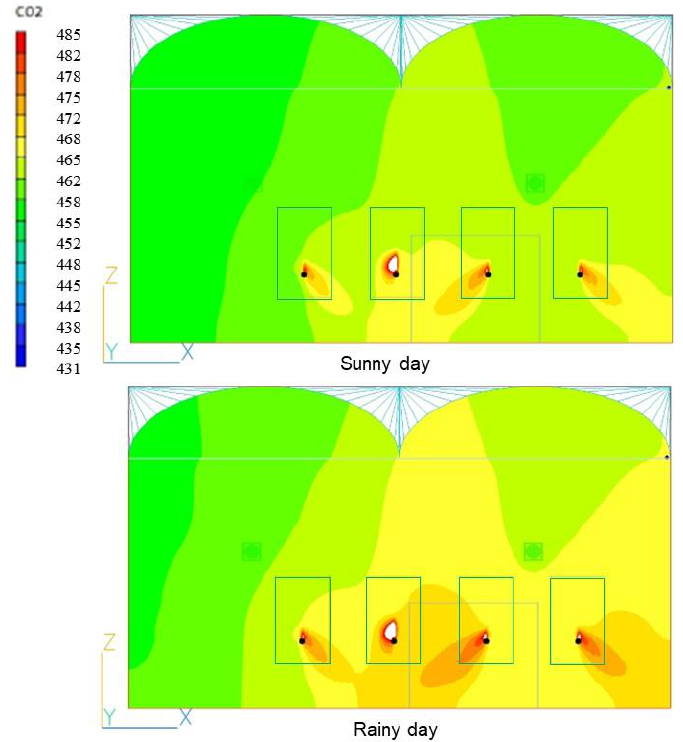
Figure 13. The CO 2 distribution inside of the greenhouse in case the sunny and rainy day (image taken at cross-section 6 m from south wall). Table 6. Coefficient of variations of CO 2 concentration in the case of sunny and rainy day.